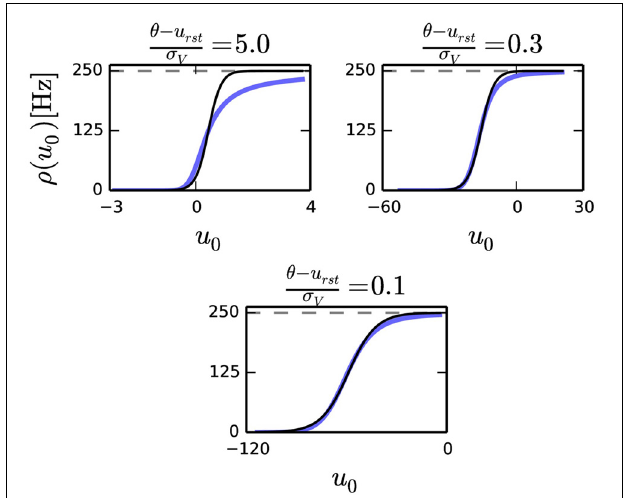
FIGURE 1 | Transfer curve of a leaky I&F neuron for three different parameter sets where u 0 = I g plot, σ V is varied to produce different ratios θ − u rst σ shows that the fit with the sigmoid function (solid black) improves as the ratio decreases.